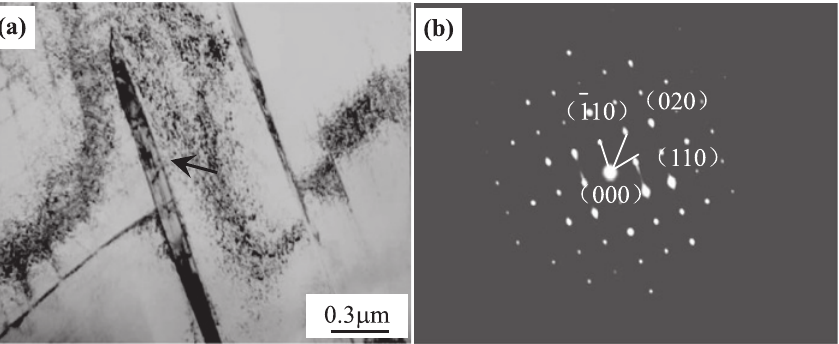
Fig. 2: Precipitation of needle-like phase in GH4169 alloy after standard heat treatment and index calibration. (a) Needle-like phase, (b) SAED of needle phase